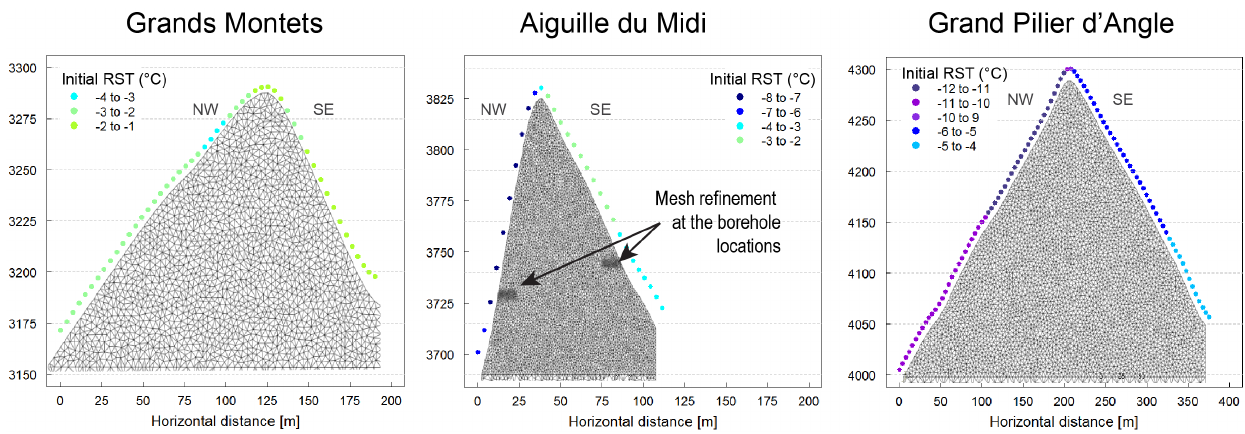
Figure 3. Boundary conditions: initial RST plotted over the models meshes for the three sites. The spatial resolution of the initial RST (coloured dots) has been refined at the mesh scale by linear interpolation. Below the topographies, a box of 5000m elevation and a constant geothermal heat flux of 85mWm − 2 were set